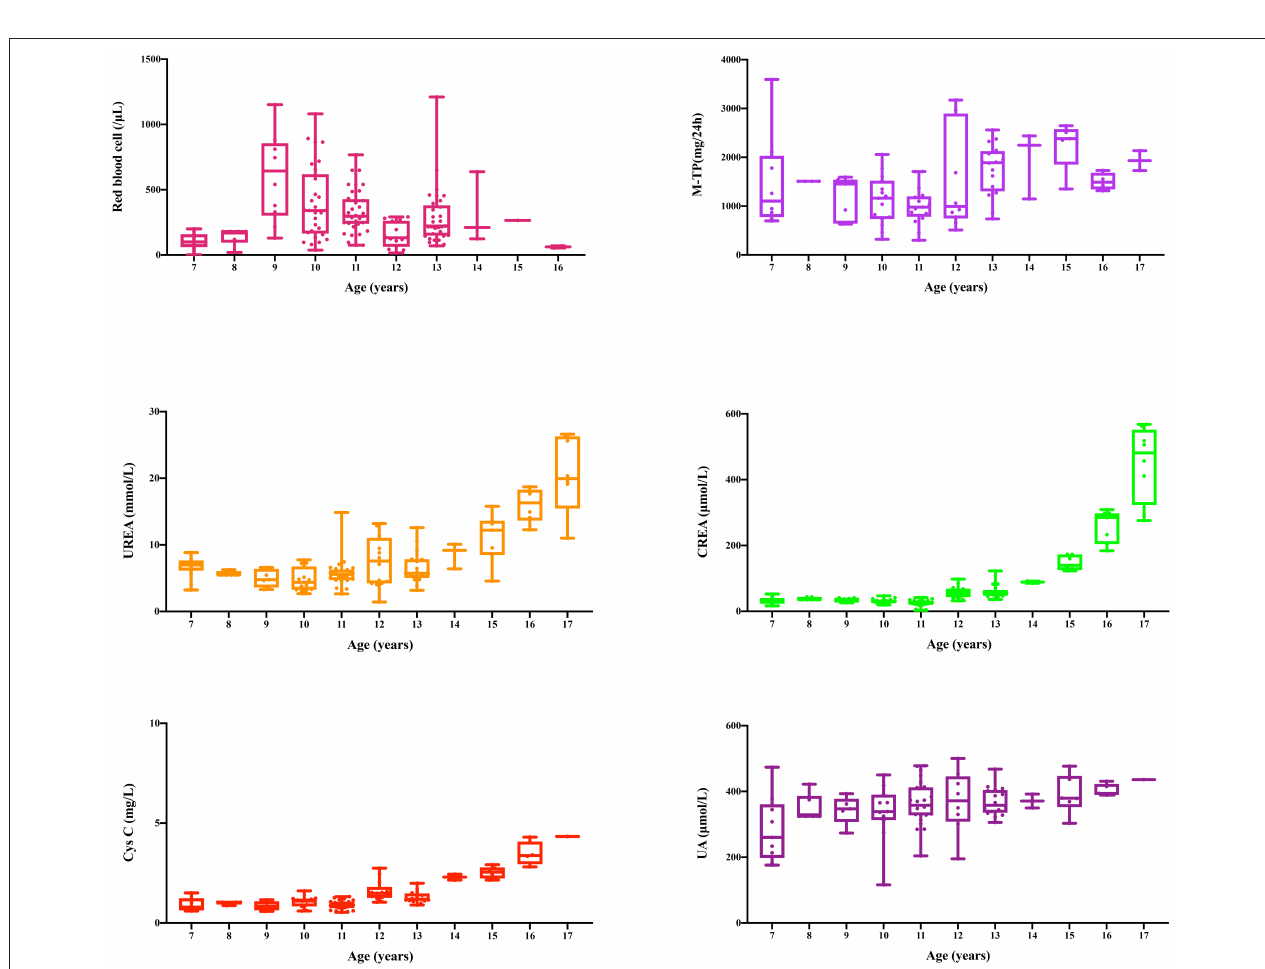
FIGURE 3 | Changes of laboratory indexes during 11 years from diagnosis to progression to uremia.